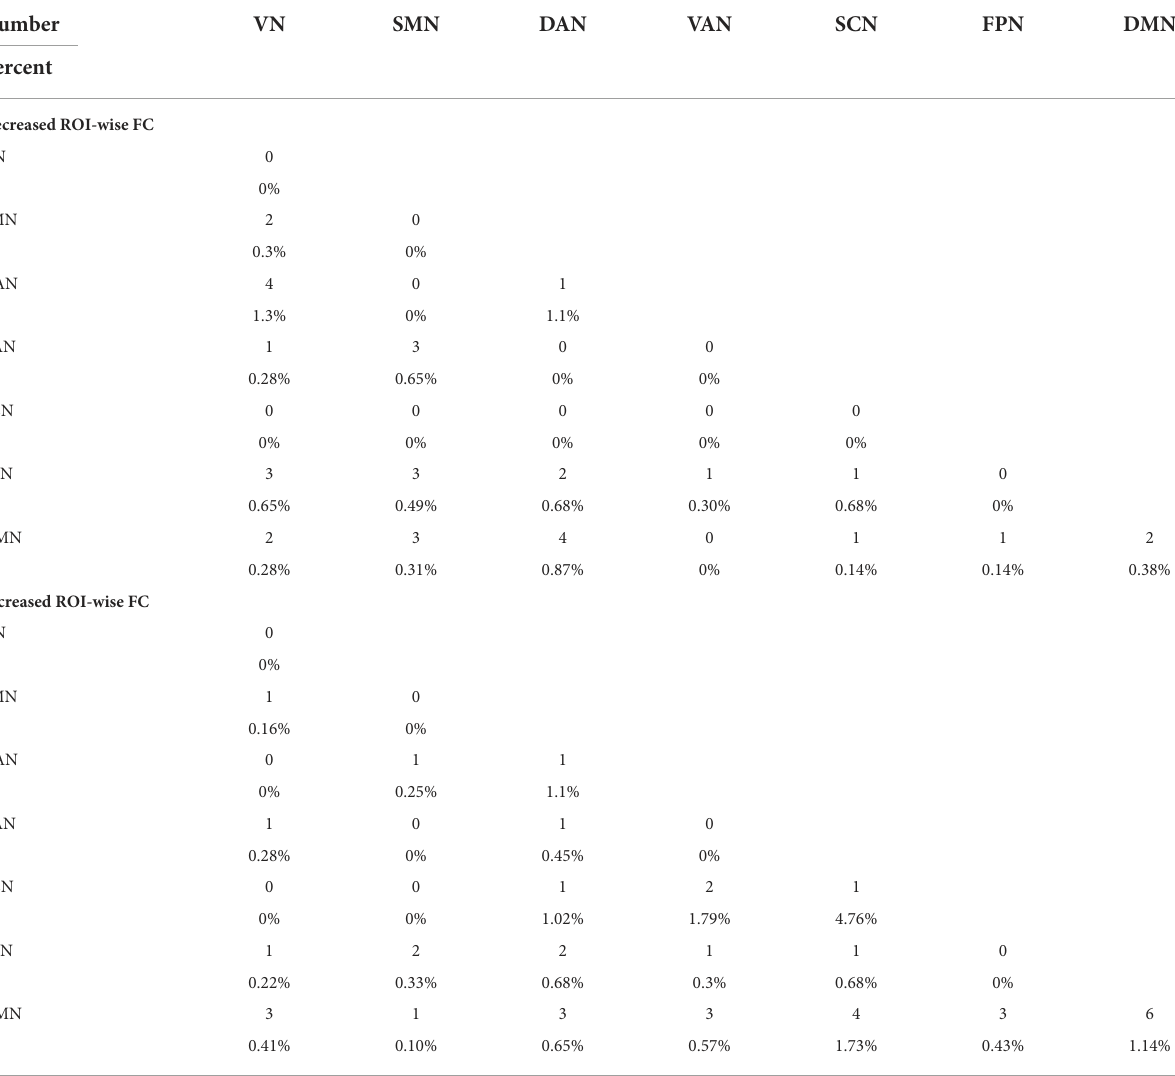
TABLE 1 Number and ratio of decreased and increased ROI-wise FC between the acute SD and RW states.